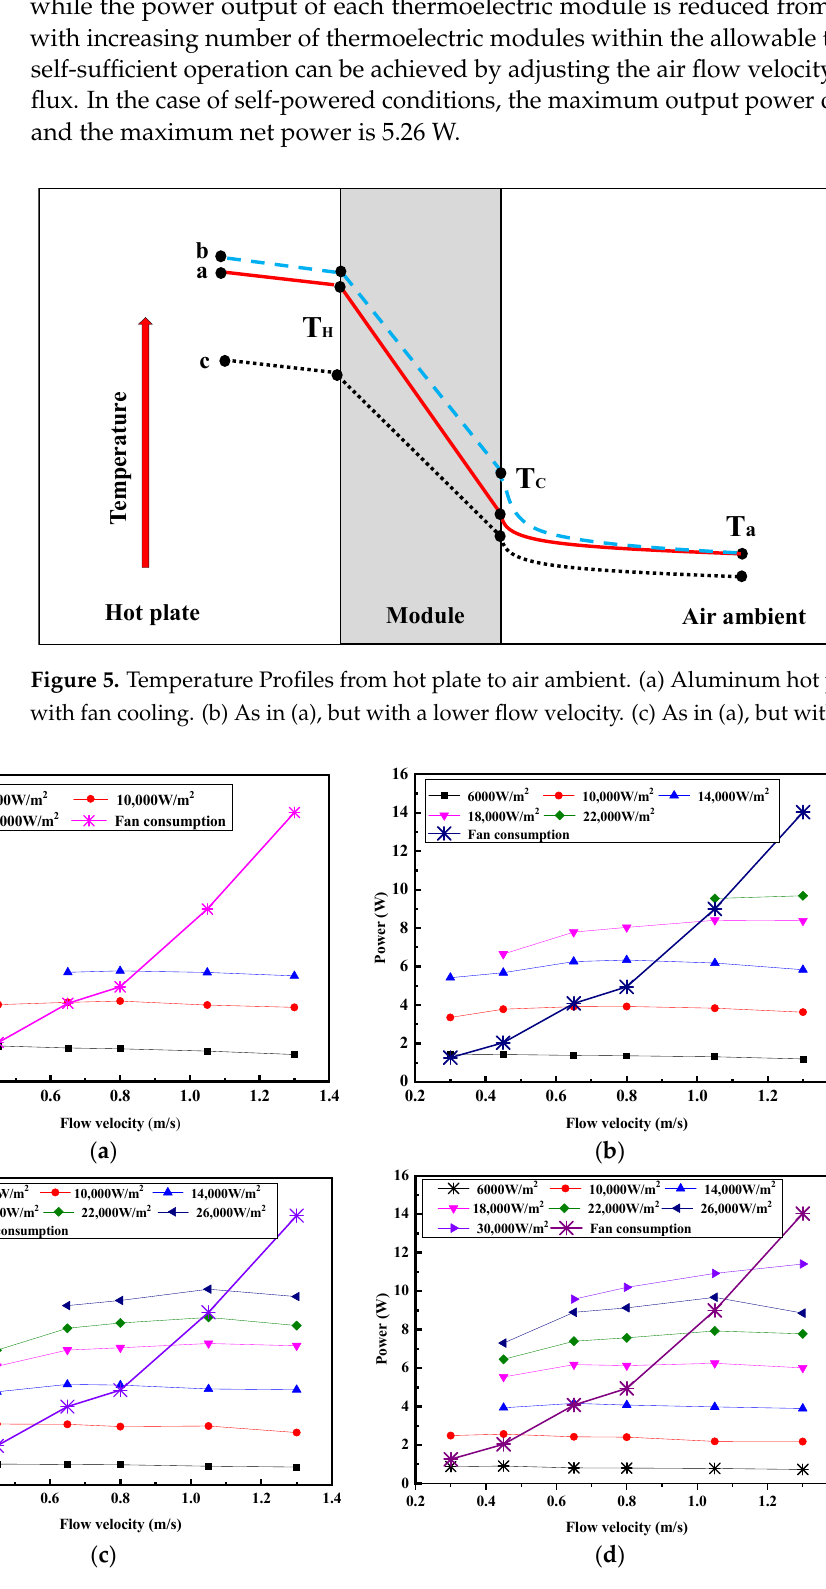
Figure 6. ( a ) one module, ( b ) two modules, ( c ) three modules, ( d ) four modules. Maximum power output at various air flow velocity and heat flux. output at various air flow velocity and heat